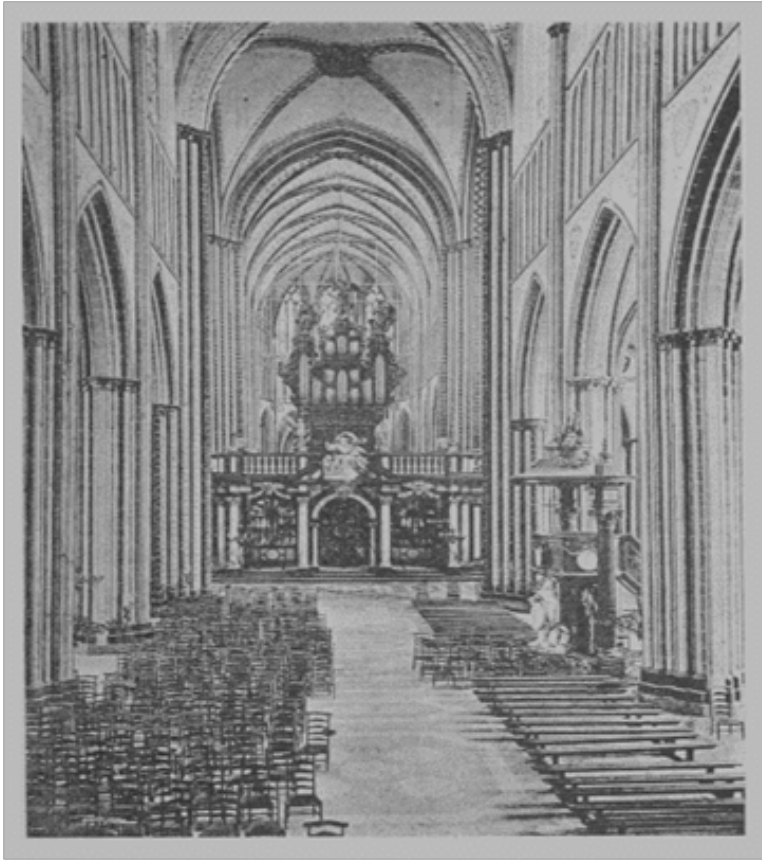
Figure 7. Anonymous. Interior of the Saint Saviour’s Cathedral in Bruges La Morte